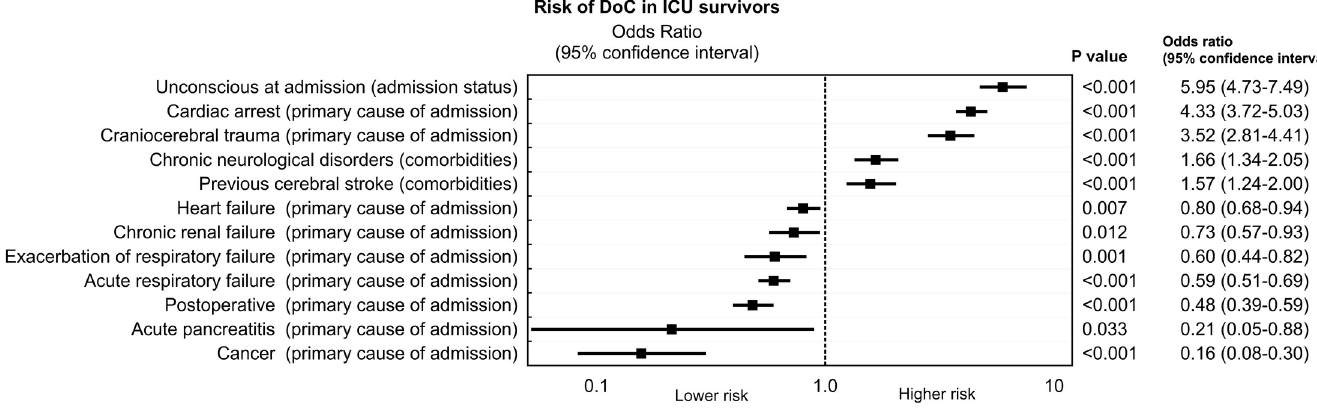
Fig 5. Multivariate analysis–independent predictors of discharge in a DoC.